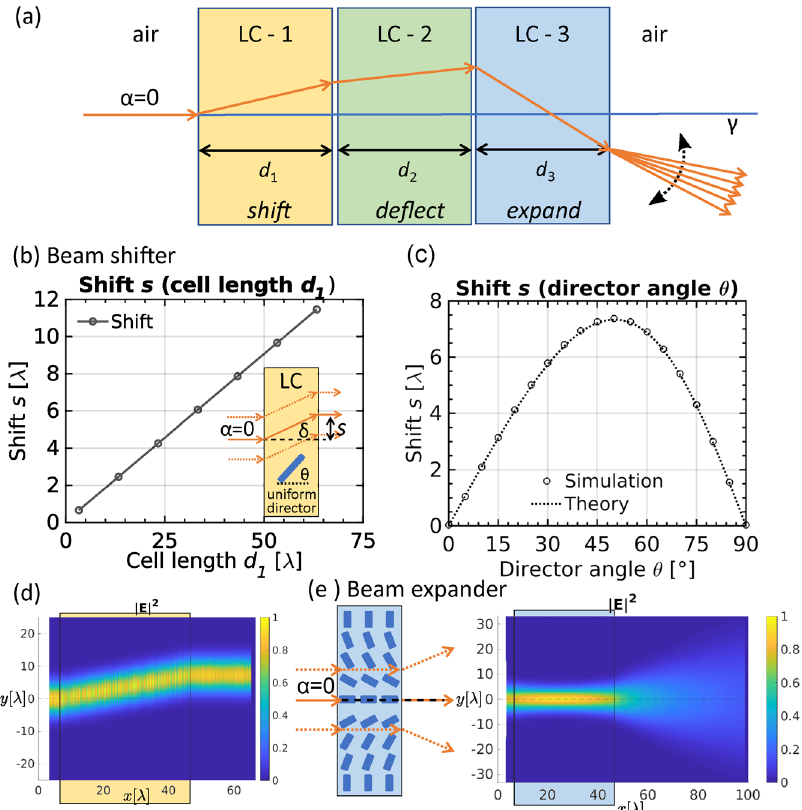
Figure 2. Liquid crystal (LC) beam control: ( a ) A schematic representation of a stack of LC building blocks. Controlling the output beam for obtaining a desired beam profile and direction is done in three steps: (i) first the incoming beam is shifted, (ii) then deflected to a certain angle and (iii) eventually expanded. Such an array of tunable building blocks can control the output beam continuously and with great precision. ( b ) Dependence of the beam shift s on the building block length d 1 for a fixed θ = 45 ◦ . (cid:31) is wavelength in vacuum. Beam shifter building block has a uniform LC director field (note the blue cylinder representing nematic director—i.e. optical axis). ( c ) Beam shift dependence on the LC director angle θ . Maximum shift is obtained, when the director is aligned at an angle of approximately 50 ◦ . Length of the block was fixed at d 1 = 40 (cid:31) . Theoretically predicted shift is obtained as s = d 1 tan δ , where δ is a walk-off angle, given by Eq. (1). ( d ) Simulated electric field intensity | E | 2 in a shifter building block for an in-plane polarized Gaussian input beam. The beam is gradually shifted throughout the building block (note the yellow box representing the shifter building block) and the shape of 2 the beam is preserved. ( e ) An example of simulated electric field intensity | E | for the expander building block: Incoming perpendicular Gaussian beam is expanded in order to illuminate a larger area, using a radially escaped LC director